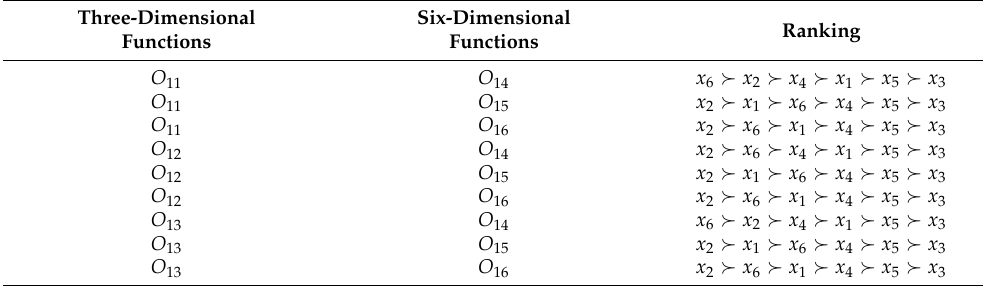
Table 12. Summary of the permutations gained with suggested means. Three-Dimensional